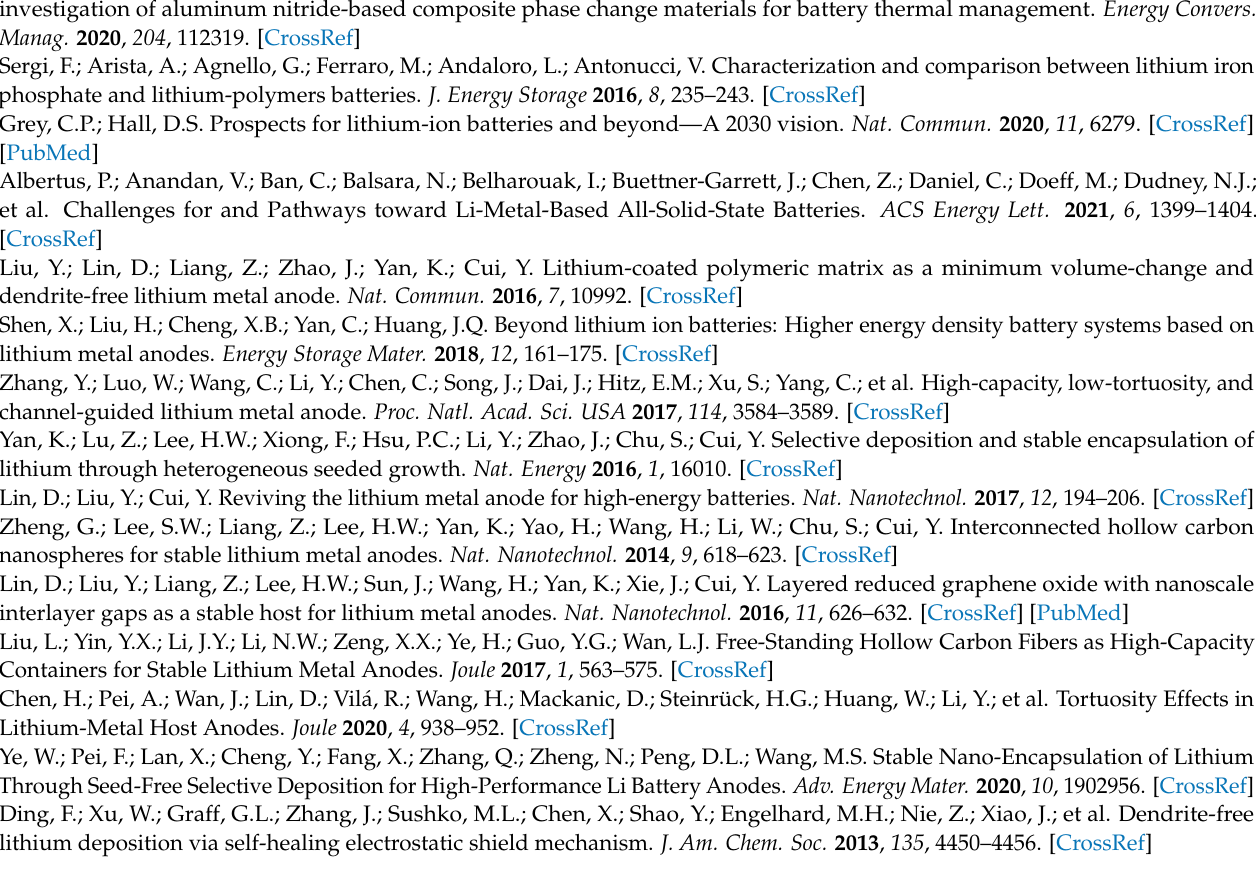
(c) 360 nm. Table S1: Parameters derived from the N 2 adsorption-desorption isotherms for various PHCCSs. Table S2: Capacity calculation parameters of PHCCSs (110 nm: 60 nm). Video S1: Visual observation of Li plating on the PHCCS-coated Cu